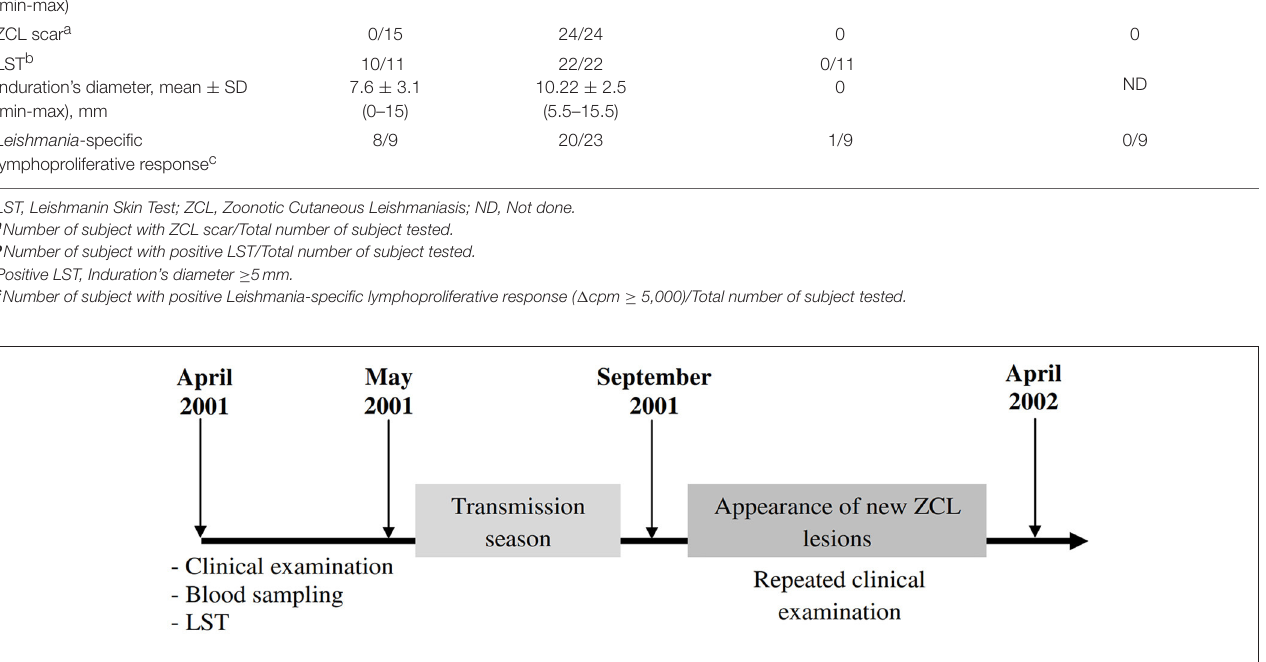
Healthy subjects living in endemic area ( n = 11 )